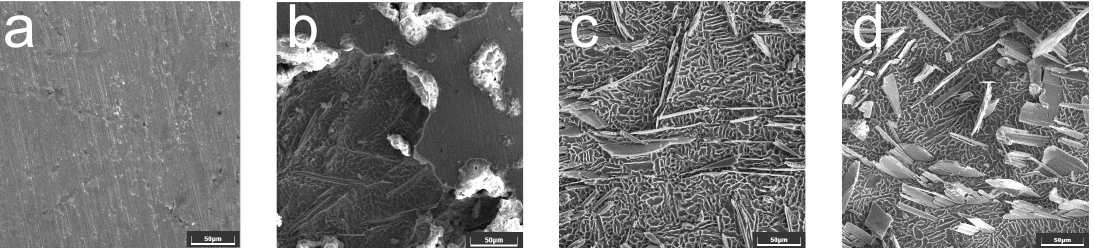
Figure 9. 500 × SEM images of samples at different processing times at current density = 30 A/cm 2 , 30 °C in a wt. 20% NaCl solution. ( a ) Processing time = 0 s, ( b ) processing time = 5 s, ( c ) processing time = 20 s, and ( d ) processing time = 100 s.